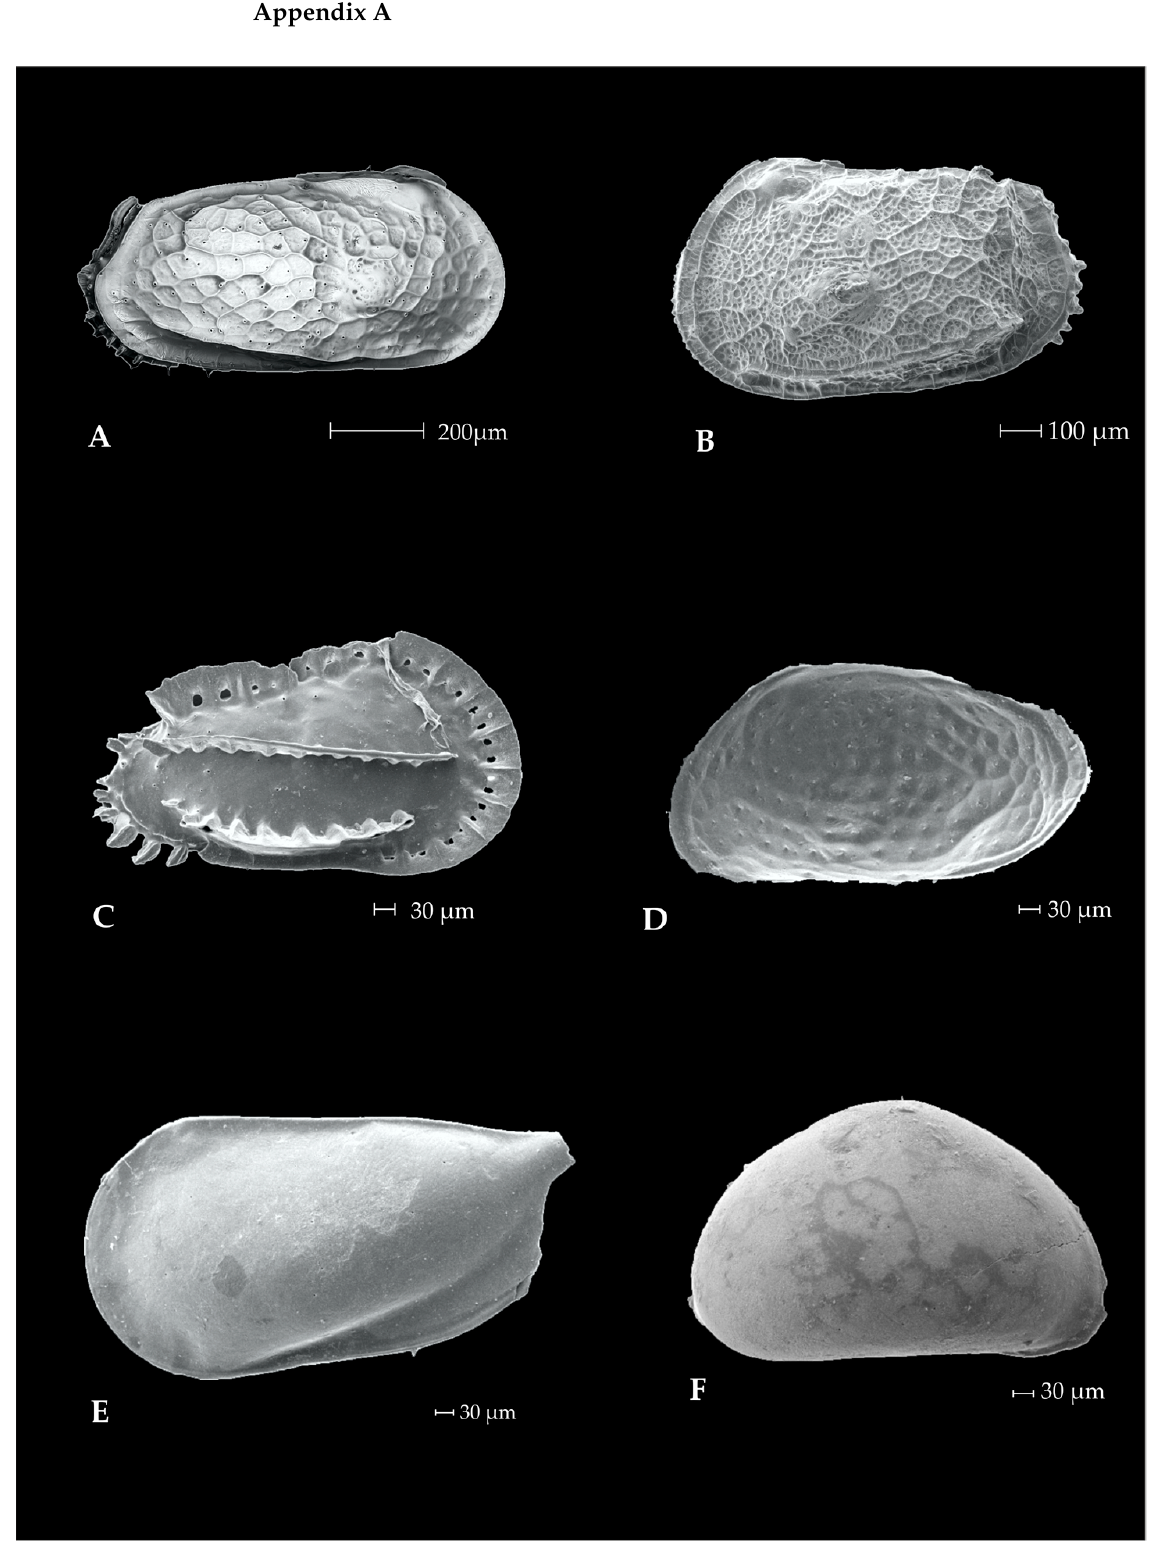
Figure A1. (NEA assemblage)—( A )— Australicythere devexa , lateral exterior view, right valve. ( B )— Australicythere polylyca , lateral exterior view, left valve. ( C )— Cativella bensoni , lateral exterior view, right valve. ( D )— Loxoreticulatum fallax , lateral exterior view, left valve. ( E )— Pseudocythere aff. P. caudata , lateral exterior view, left valve. ( F )— Xestoleberis rigusa , lateral exterior view, right valve.